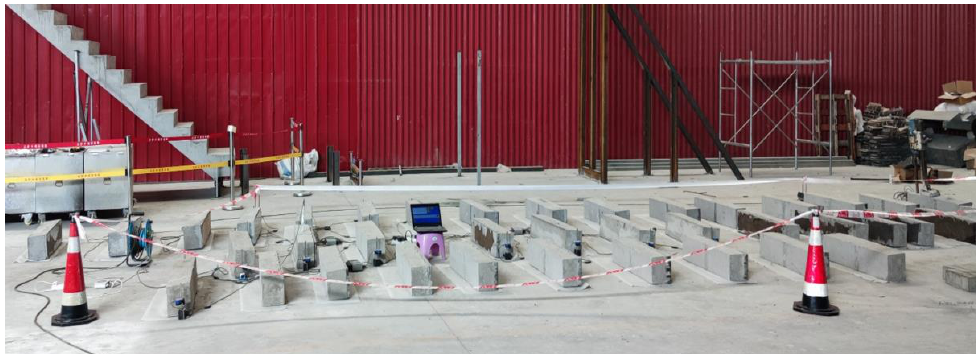
Figure 3. Schematic diagram of the field test situation.